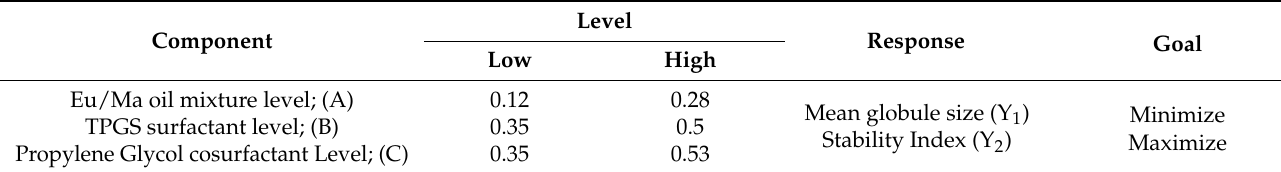
Table 6. Experimental plan of mixture design (component levels and selected